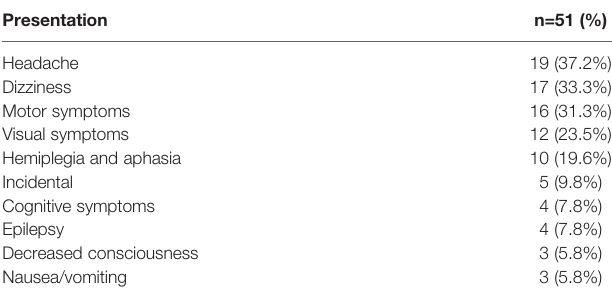
TABLE 1 | Initial presentations of the 51 PCNS-DLBCL patients at diagnosis. Presentation